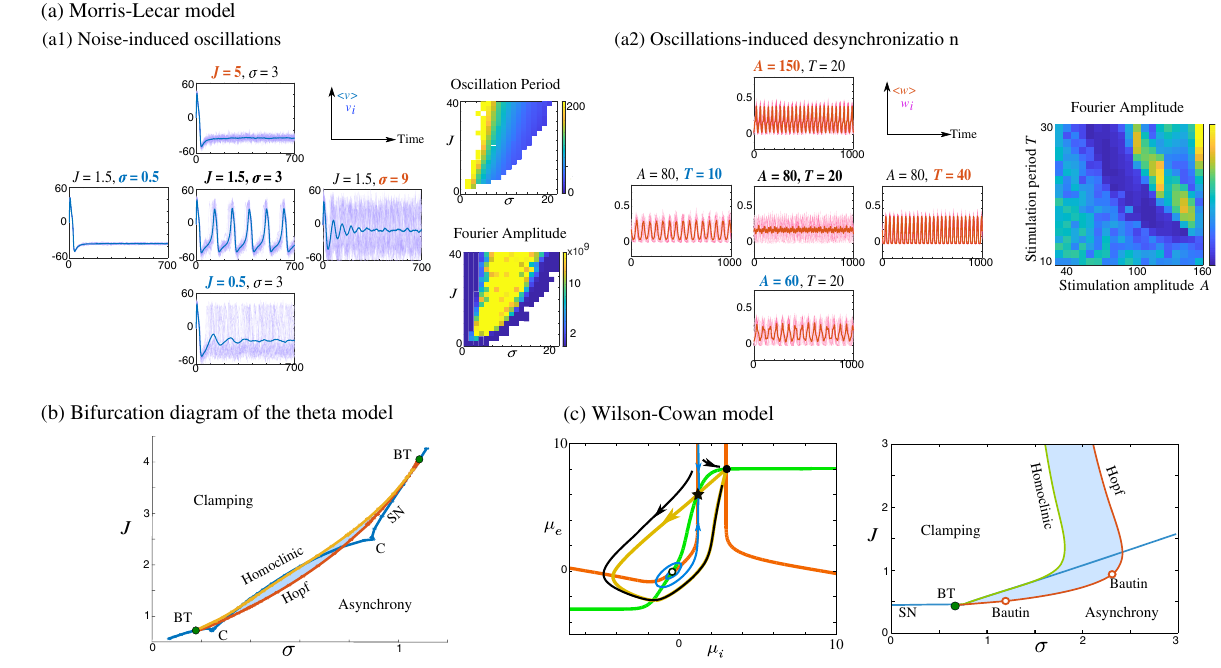
FIG. 8. Universality of the transitions. (a) Morris-Lecar model. Noise-induced transition and oscillations-induced desynchronization; parameters as in Table 3.1 of Ref. [6] (SNLC), with ϕ ¼ 0 . 02 , V 1 ¼ − 1 . 3 , V 4 ¼ 10 , and basic applied current I ¼ 35 . (a1) shows the noise-induced synchronization phenomenon as a function of coupling strength J and noise σ . Trajectories, 20 sample voltage traces (dark blue) and mean (bold cyan); heat maps, statistics of the synchronization via Fourier transform peak period (top) and amplitude (bottom) as a function of coupling strength and noise. (a2) Responses of the system within the noise-induced oscillations regime ( J ¼ 1 . 5 , σ ¼ 3 ) to a Lilly pulse Eq. (8) for various frequencies and amplitudes; at appropriate frequency and amplitude, oscillations disappear (center). Trajectories, 20 sample recovery variable traces (red) and mean (bold black); heat map, amplitude of the Fourier transform as a function of period and amplitude of the stimulation. (b) The theta neuron with a ¼ 0 . 04 . Two-parameter bifurcation diagram of the Fokker-Planck equation of the theta neurons as a function of coupling strength and noise shows a saddle-node bifurcation manifold (blue) and a Hopf bifurcation manifold (red), together with two codimension-two cusp and two Bogdanov-Takens (BT) bifurcations, associated with a branch of saddle-homoclinic bifurcation (yellow). The Hopf and homoclinic bifurcation curves delineate an eye-shaped noise-induced synchronization regime (sky blue region). (c) The excitatory-inhibitory Wilson-Cowan mean-field system 15 , g − 12 , g 16 , g − 5 , I 0 , I − 3 , S ð x Þ ¼ erf ð 3 x Þ . The system exhibits an intrinsic excitable structure with g ee ¼ ei ¼ ie ¼ ee ¼ e ¼ i ¼ (left) with a single stable fixed point (black circle) and a saddle fixed point (black star) whose stable (blue) and unstable (yellow) manifolds organize the excitability. Green and red curves are the nullclines of the system. Right: Two-parameter bifurcation diagram of the excitatory-inhibitory Wilson-Cowan system features a Hopf (red solid line, supercritical; red dashed line, subcritical; red circle, codimension-two Bautin bifurcation) and a saddle-node (blue) bifurcation colliding at a Bogdanov-Takens bifurcation (green circle), from which point emerges a homoclinic bifurcation (green line). Near the BT point, the saddle-node bifurcation shows a cusp (not visible in the diagram). The homoclinic and Hopf bifurcations delineate a region of noise-induced oscillations (blue) that extends slightly beyond the Hopf curve between the two Bautin bifurcations and disappear through a fold of limit cycles (not shown). As noise is increased, oscillations emerge from clamped regimes through the homoclinic bifurcation and disappear through the Hopf bifurcation (or the fold of limit cycles) into an asynchronous